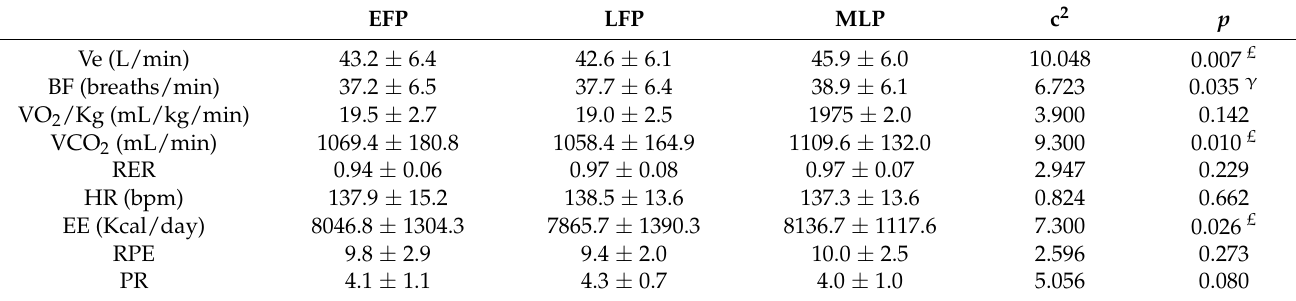
Table 3. Performance variables throughout the cool down across the menstrual cycle